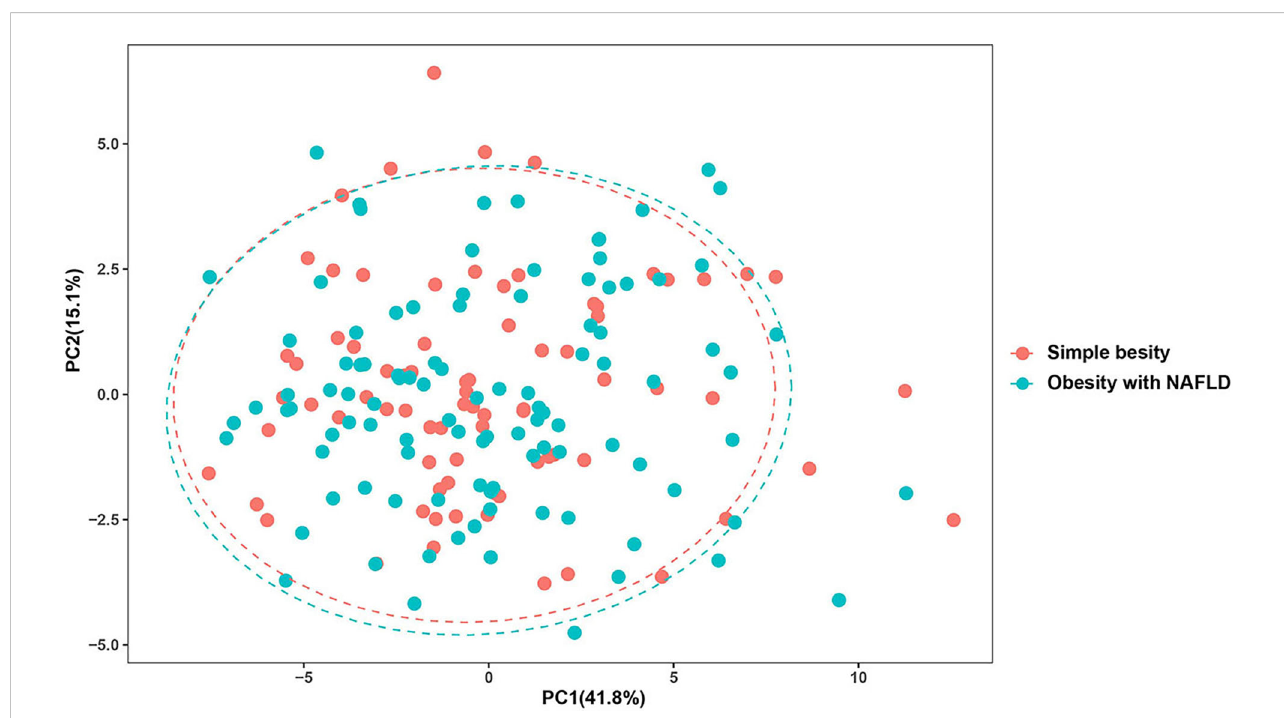
FIGURE 2 Principal component analysis of the dominant gut microbiota in obesity with NAFLD and simple obesity.